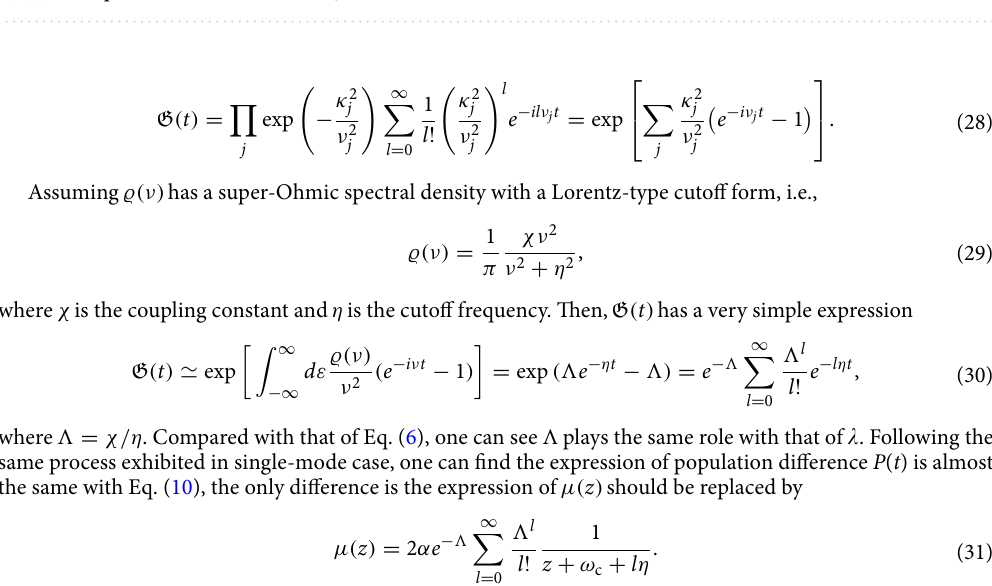
Figure 2. δ P ( t ) is plotted as the function of time with different steer parameters: (cid:31) = 0.02 (yellow circles), (cid:31) = 0.05 (magenta stars), (cid:31) = 0.1 (blue diamonds) and (cid:31) = 0.2 (red squares). The initial state of the TLS is | e �� e | , other parameters are chosen as η = 30cm − 1 , ω c = 5 cm − 1 and α = 0.1cm − 1